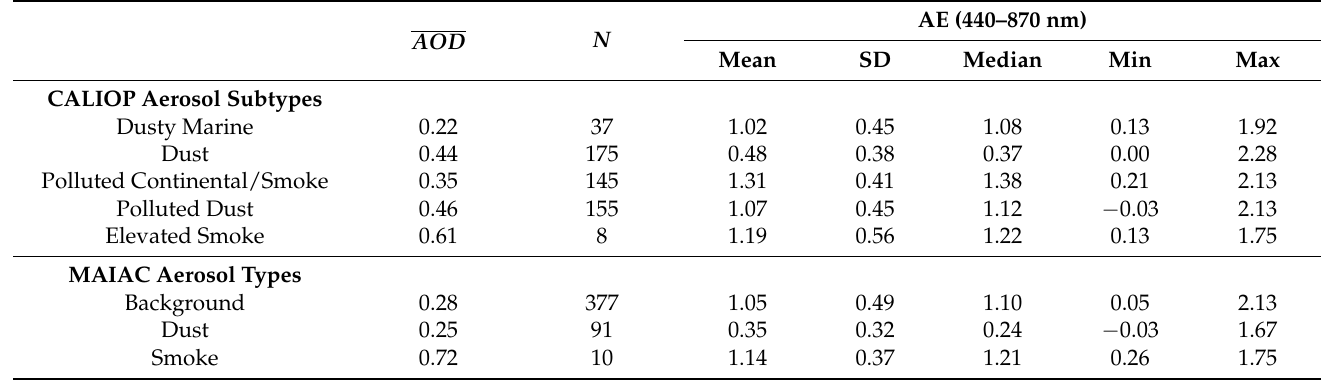
Figure 5. Boxplots of AERONET AE distributions for different CALIOP ( left ) and MAIAC ( right ) aerosol types. CALIOP aerosol types: (DD) dust, (PD) polluted dust, (PC/S) polluted continental/smoke, (DM) dusty marine, and (ES) elevated smoke. MAIAC aerosol types: (D) dust, (B) background, and (S) smoke. Box lower and upper borders represent the 25th and 75th percentiles of the data respectively (i.e., the inter quartile range, IQR). The inner lines are the medians, green triangles are the means, the upper whisker represents the 75th percentile + 1.5 × IQR, and the lower whisker represents the 25th percentile − 1.5 × IQR. Table 1. AERONET AE statistics for different CALIOP and MAIAC aerosol types (the overbar represents arithmetic mean).